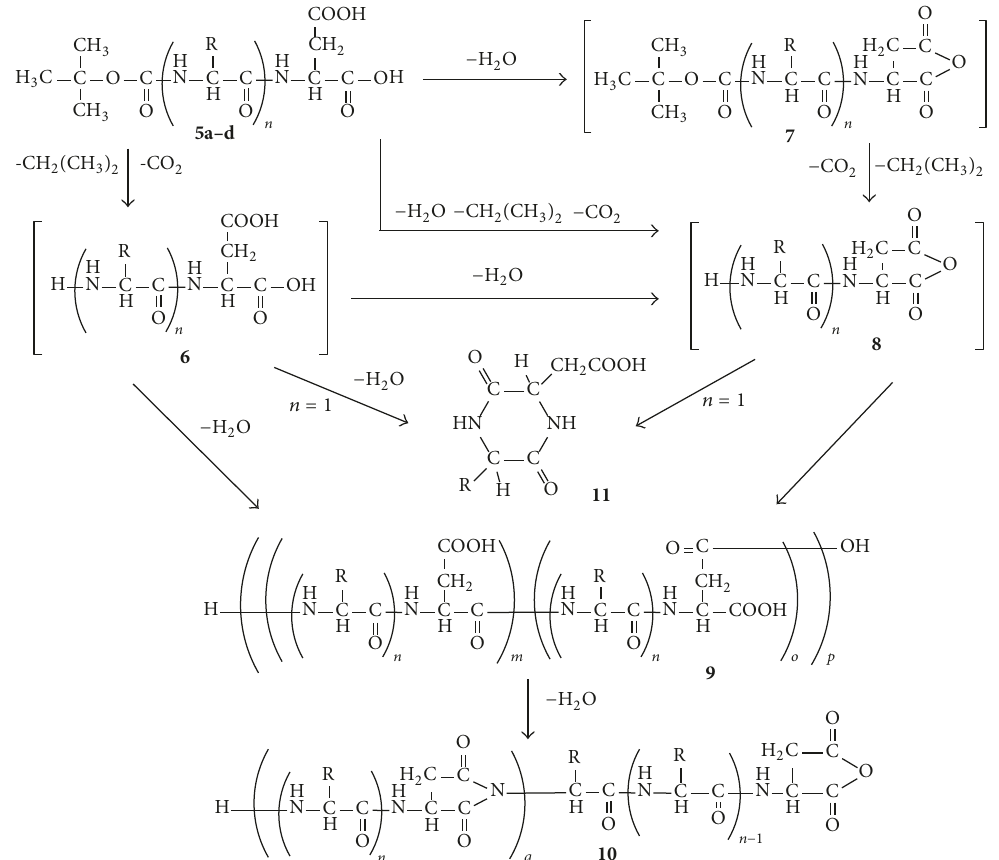
Figure 14: Postulated mechanism of the thermal reaction of Boc-peptides ( 5a–d ). 𝑛 = 1 for 5a–c ; 𝑛 = 2 for 5d . 𝑚 , 𝑛 , 𝑜 , 𝑝 , and 𝑞 : natural number ( 0, 1,2, 3, .. . ).